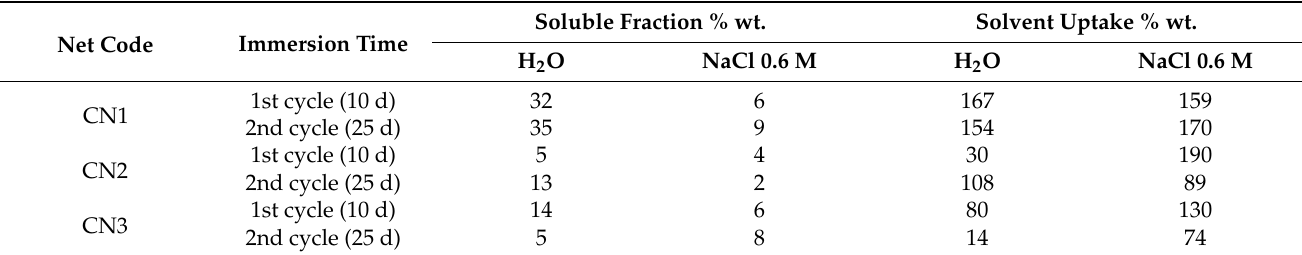
Table 3. Soluble fraction % wt. and solvent uptake % wt. of the coated nets after immersion in water and aqueous 0.6 M NaCl solution for 25